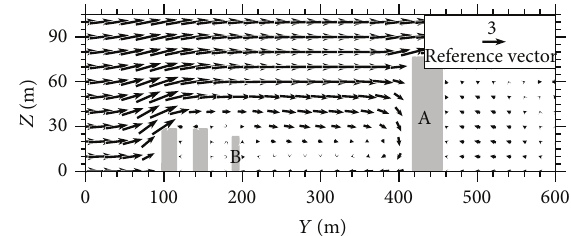
Figure 12: The vertical plane of the wind vector field across 𝑋 = 325